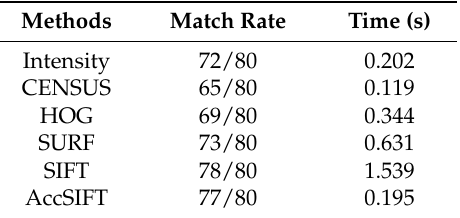
Table 2. Comparison of different descriptors on the Wuhan data.